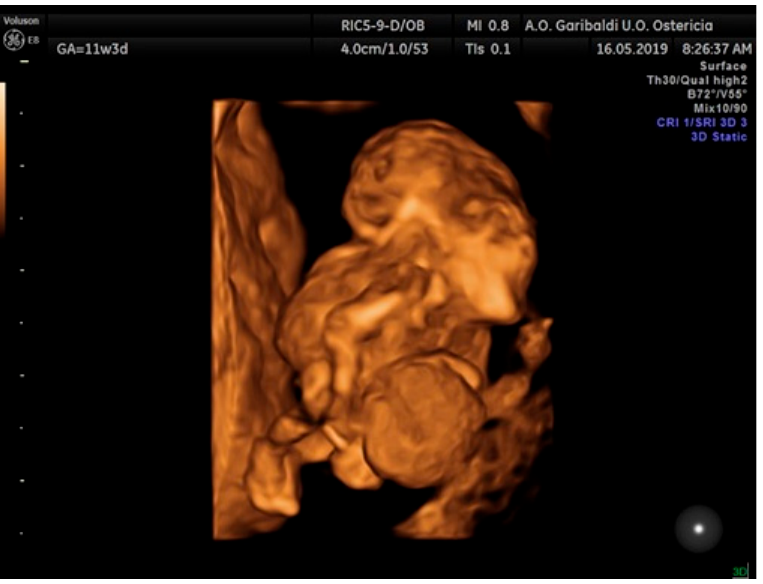
Figure 1. 3D Image of case report 1 at 11 weeks.